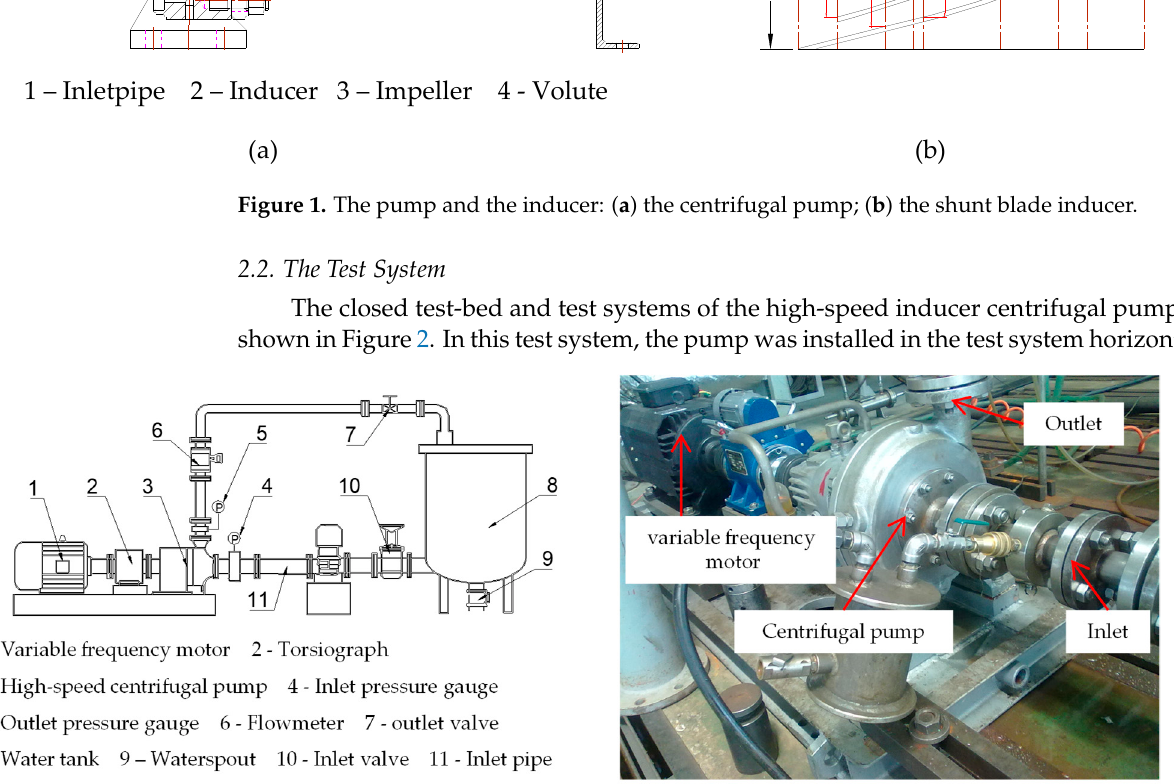
Figure 1. The pump and the inducer: ( a ) the centrifugal pump; ( b ) the shunt blade inducer. Table 1. Parameters of the pump.